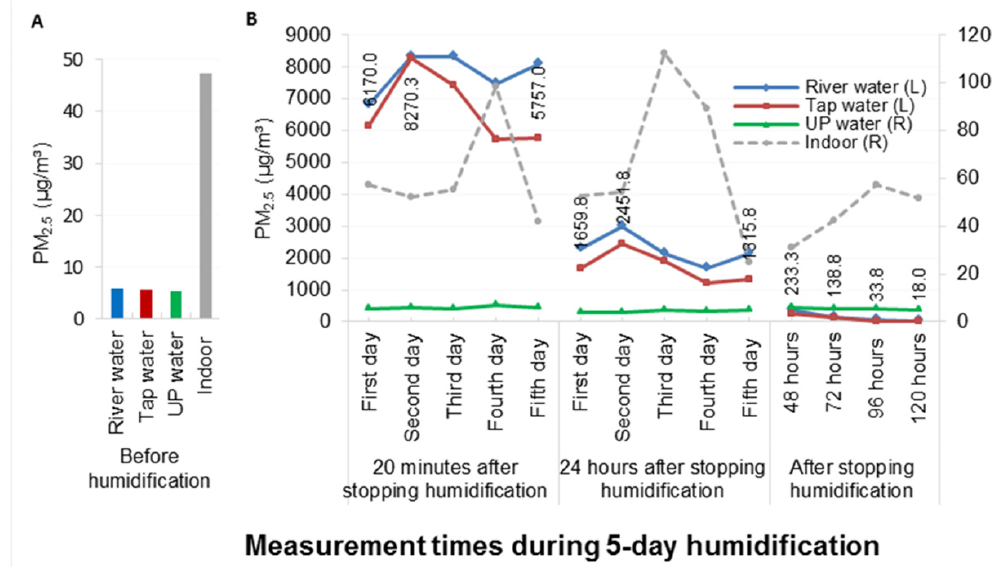
Figure 1. PM 2.5 concentration in three sealed chambers and in the surrounding room before humidification ( A ) and after stopping humidification ( B ) in a five-day humidifying experiment. In panel B, PM 2.5 concentrations between three types of water were different (DF = 2, F = 61.06, p < 0.0001), and PM 2.5 concentrations between different time points (excluding ultrapure water) were also different (DF = 13, F = 55.5, p < 0.0001). Further multiple comparisons (LSD) showed that PM 2.5 concentrations in tap water and river water were higher than those in ultrapure water ( p < 0.05), but there was no difference in PM 2.5 concentrations between tap water and river water ( p > 0.05); the order of average PM 2.5 concentrations between different time points was 20 min > 24 h > 48–120 h ( p < 0.05). PM 2.5 concentration decreased to a minimum on the fifth day after humidification ended. The marked numbers are the tap water results.